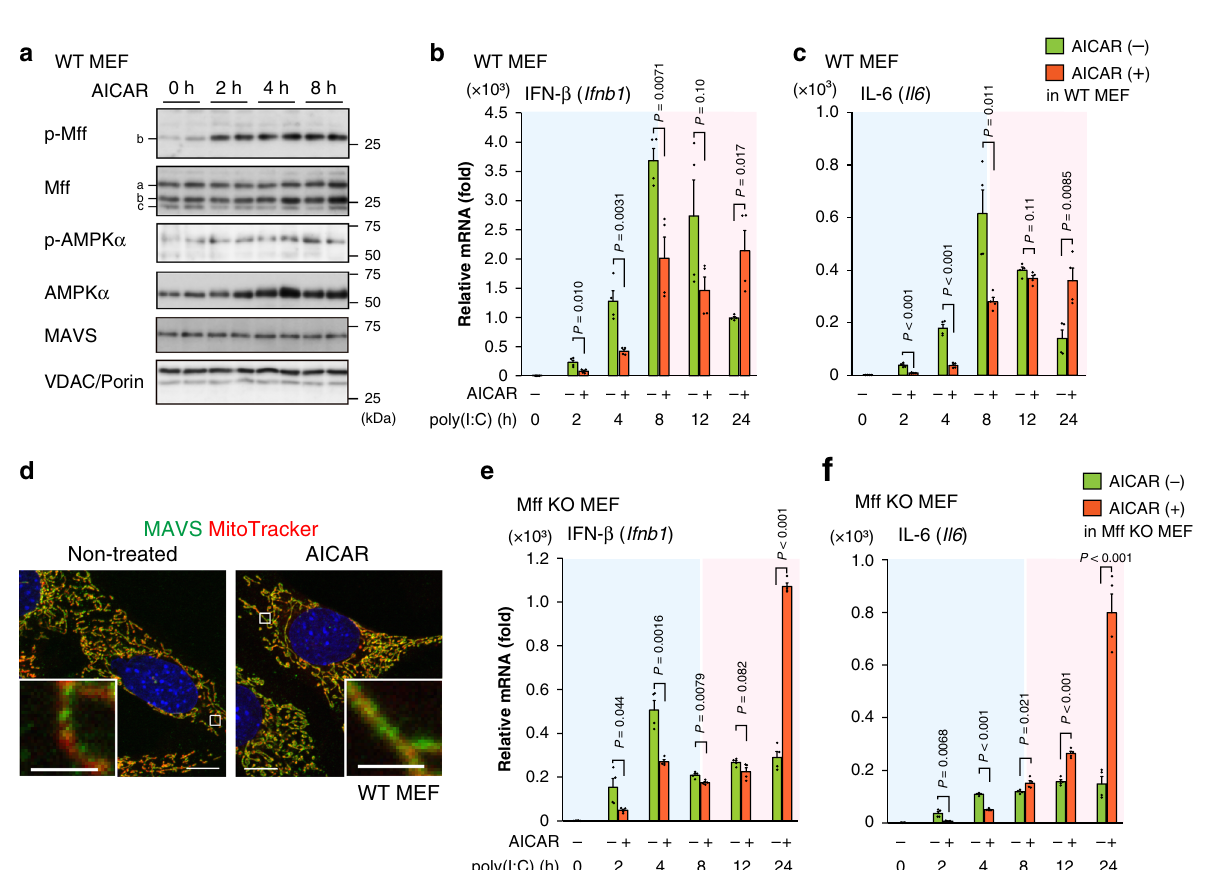
Fig. 3 Mff regulates MAVS-mediated antiviral response independent of mitochondrial fi ssion. a Scheme of murine Mff deletion constructs. The amino acid numbering scheme used in the constructs corresponds to splice isoform 8 of Mff 13 . TM: transmembrane domain. b Confocal microscopic images of Mff and mitochondria. Mff KO MEFs were transfected with expression vectors for FLAG-tagged Mff (WT), Mff ( Δ C20), or Mff ( Δ N100), stained with MitoTracker Red (mitochondria; red), and immunostained with an anti-FLAG antibody (green). Nuclei were stained with DAPI (blue). Scale bars: 10 μ m. c qRT-PCR analysis of IFN- β mRNA in WT MEFs, Mff KO MEFs, and Mff KO MEFs transfected with an empty vector or expression vectors for FLAG-tagged Mff (WT), Mff ( Δ C20), or Mff ( Δ N100). Cells were transfected with or without poly(I:C)-LMW (1 μ g/mL) for 8 h. Data represent means ± SEM from three independent experiments (vector, WT, Δ C20, Δ N100: n = 6, 4, 4, 5, P value; two-tailed unpaired t test). d Immunoblot analyses of endogenous and exogenous Mff and Mff phosphorylation in the cells listed in c . The indicated letters (a, b, c) correspond to the endogenous Mff bands observed in WT MEFs. e Confocal microscopic images of MAVS and Mff. Mff KO MEFs transfected with expression vectors for Mff (WT), Mff ( Δ C20), or Mff ( Δ N100) were immunostained with anti-MAVS (green) and anti-Mff (red) antibodies. Nuclei were stained with Hoechst 33342 (blue). A magni fi ed view of the boxed region is shown below. Scale bars: 10 μ m (whole) and 2 μ m (magni fi ed). f Magni fi ed images of MAVS on mitochondria in Mff KO MEFs co- transfected with each Mff mutant and a mitochondrial marker mitoRFP (red). Cells were immunostained with anti-MAVS antibody (green). Scale bars: 2 μ m. g Co-localization ratio between MAVS and mitoRFP in WT MEFs or Mff KO MEFs co-transfected with mitoRFP and an empty vector or each Mff mutant. Data represent means ± SEM (WT-vector, Mff KO-vector, Mff KO-WT, Mff KO- Δ C20, Mff KO- Δ N100: n = 15, 13, 16, 16, 16, P value; two-tailed unpaired t test). h Working hypothesis for the coupling of the distribution of MAVS and mitochondrial fi ssion by Mff. mito: mitochondria. Immunoblot and microscopic analyses were repeated independently three times with similar results. Source data are provided as a Source data fi le.